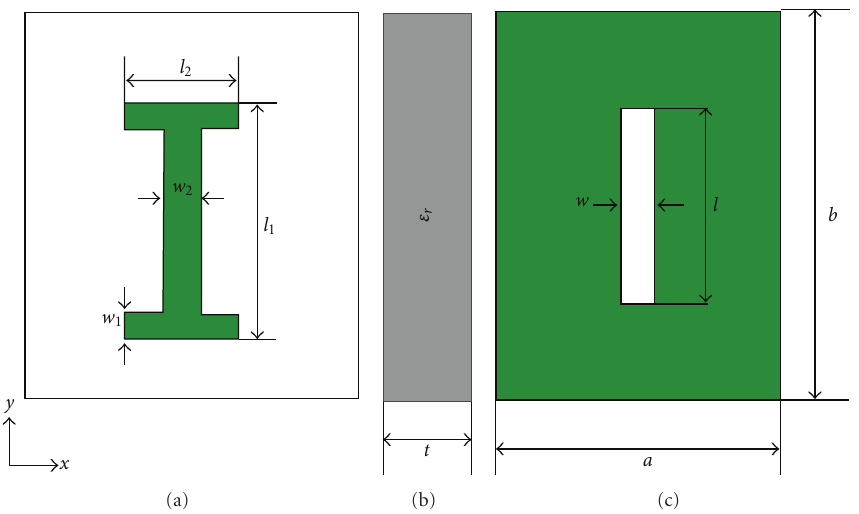
Figure 11: Geometry of a circular polarizer. (a) Metallic pattern on the top surface. (b) Cross-section. (c) Metallic pattern on the bottom surface.